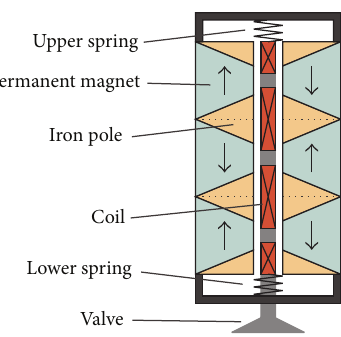
Figure 1: Cross-section of the perpendicular linear actuator.